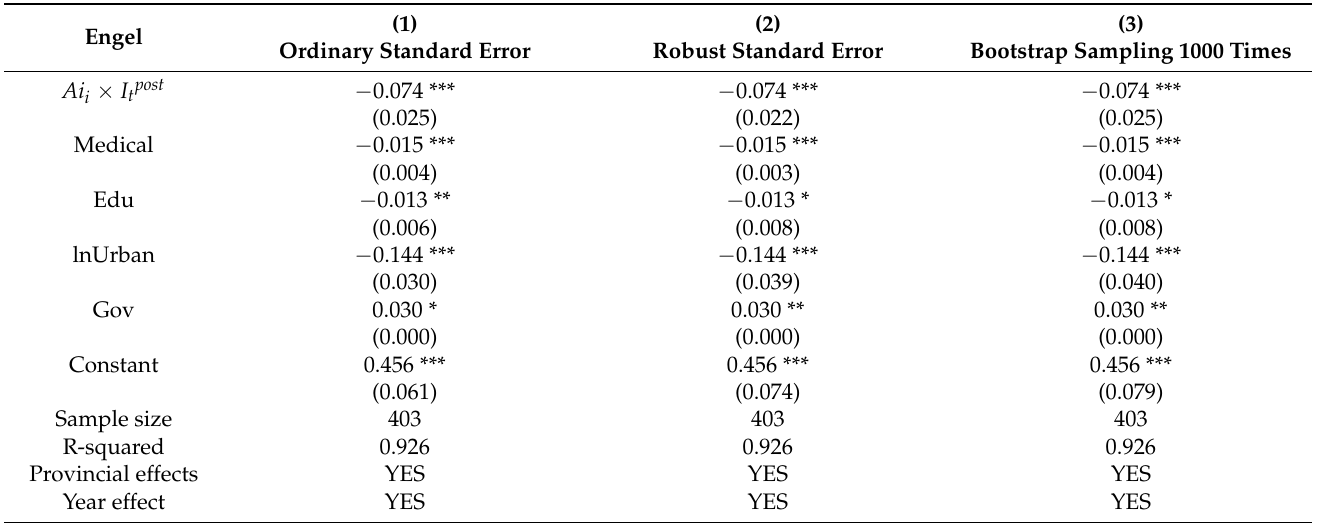
Table 2. Baseline estimation